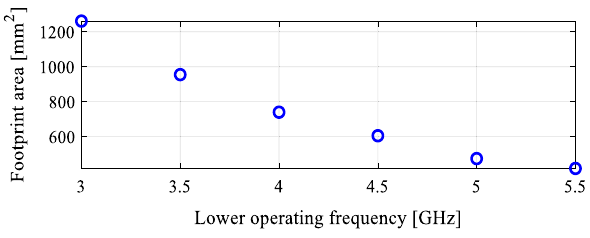
Figure 9. Trade-off designs for the CP antenna of Fig. 7. minimum attainable footprint area versus the lower end of the operating bandwidth (minimum value of the upper end equals 7.5 GHz for all cases).